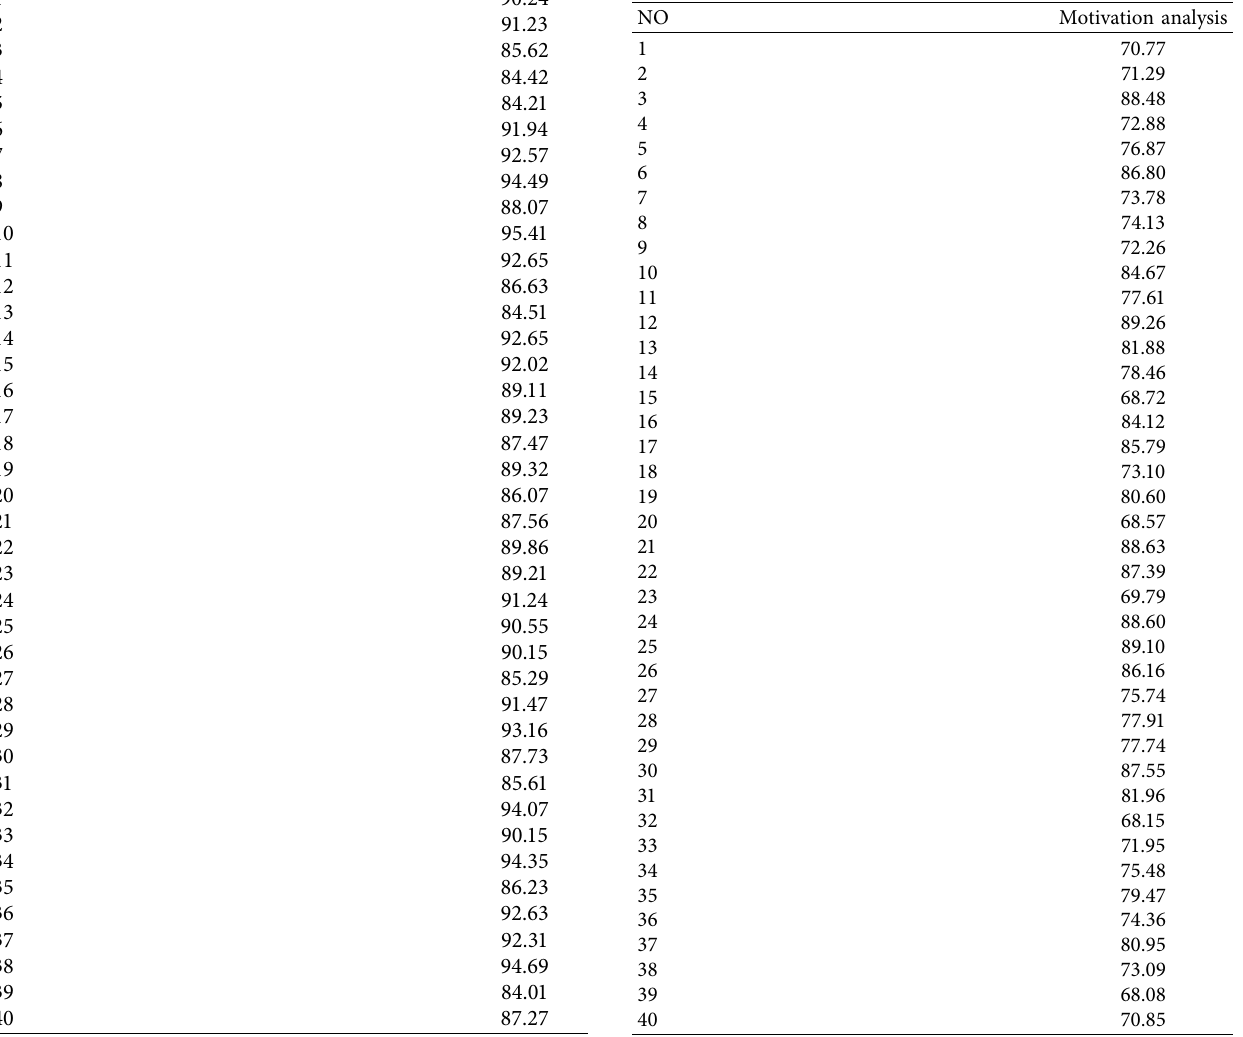
Table 1: Evaluation of the effect of data mining. Table 2: Evaluation of the motivation analysis effect of the mo- tivation analysis model of the technological startups business model based on intelligent data mining